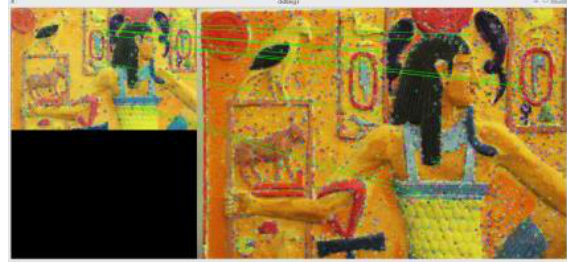
Figure 8. Acquisition of points with the same name from local images and point cloud RGB images 2.2.5 High Precision automatic Registration of Point